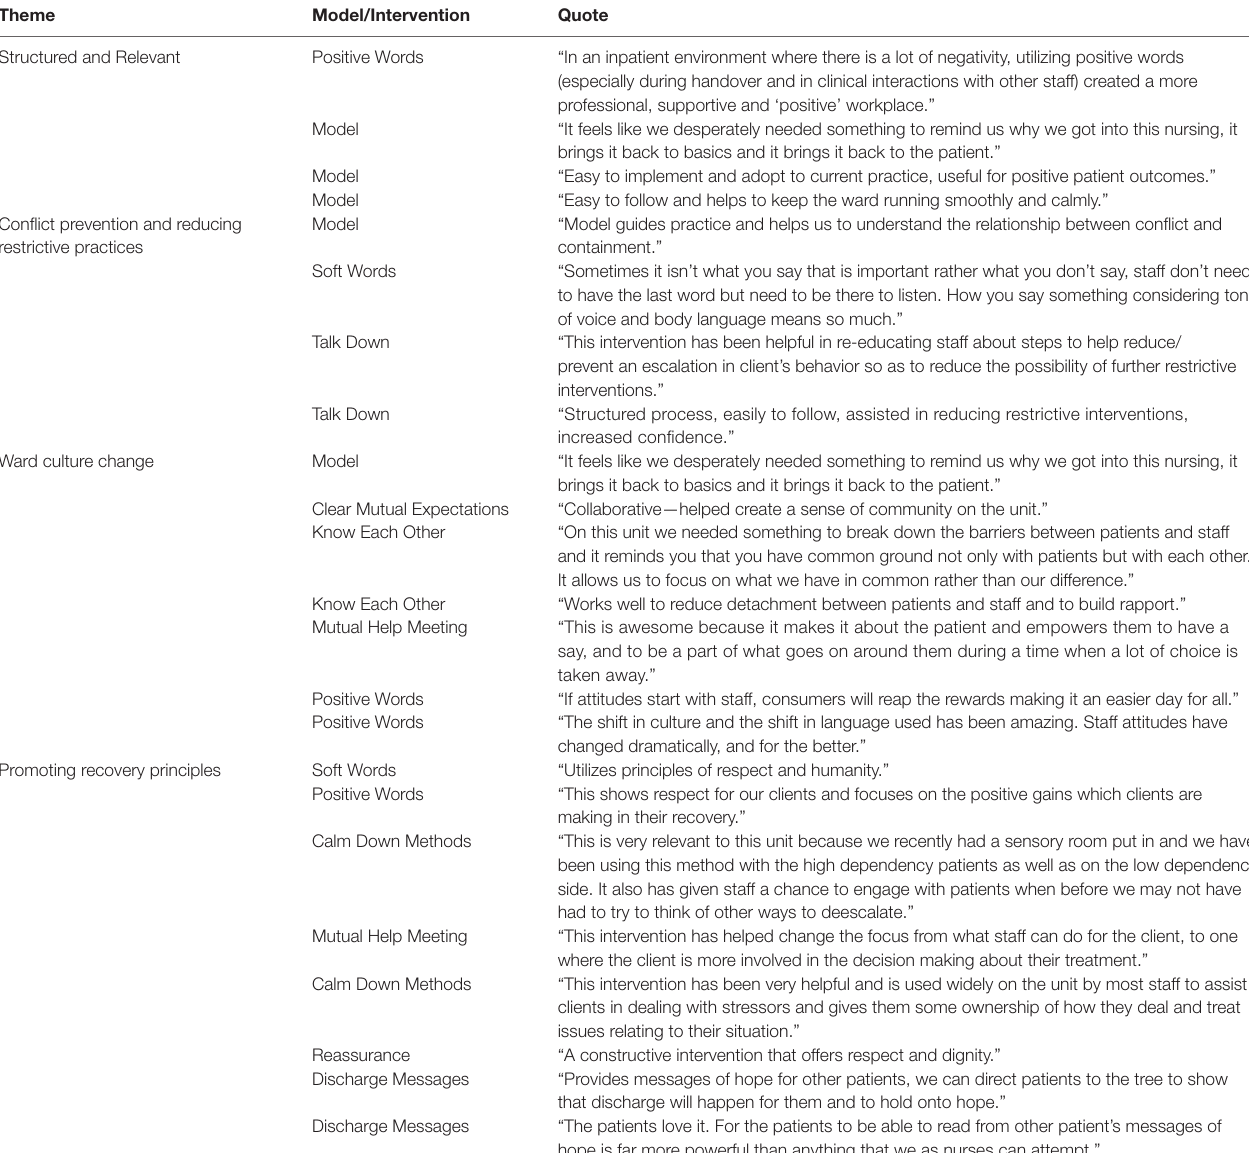
TABLE 4 | Staff quotes related to themes and specific Safewards interventions or the